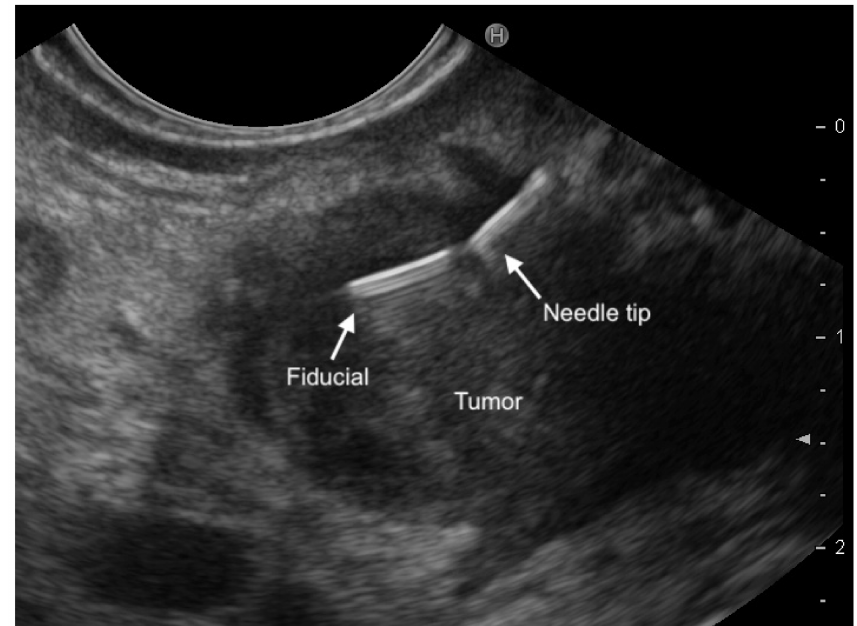
Figure 4. A magnified endoscopic ultrasound view demonstrating a fiducial just released inside a small pancreatic